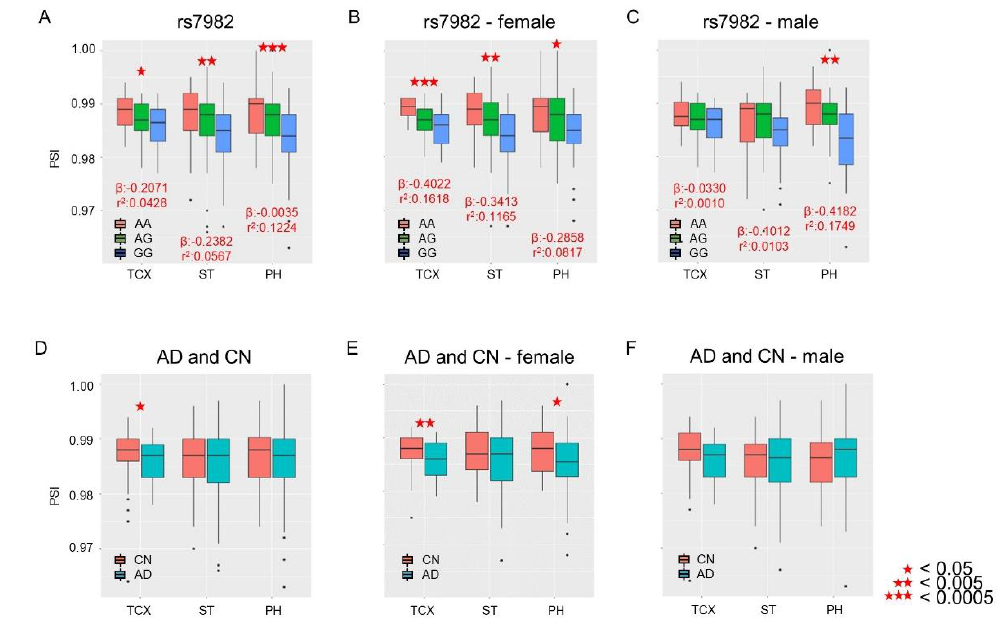
Figure 2. Associations of PSI levels of the 5th exon of CLU with rs7982 and AD diagnosis. The X -axis represents temporal lobe regions: temporal cortex (TCX), superior temporal gyrus (ST), and Parahippocampal gyrus (PH). The Y -axis represents the PSI level, i.e., rate of intron retention (IR). Top: Association of IR with the rs7982 genotype as a continuous variable, with the numbers of alternative alleles (i.e., AA = 0, AG = 1, GG = 2) tallied for all samples ( A ): females only ( B ); males only ( C ). Bottom: Association of IR with AD (cognitively normal older adults (CN) vs. AD) for all samples ( D ): females only ( E ); males only ( F ). Black dots indicate outliers.